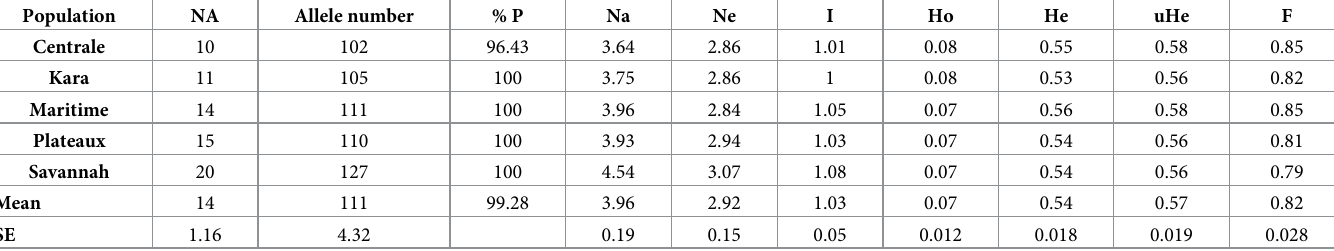
Table 4. Summary of different cowpea population diversity statistics averaged over the 28 SSR loci. Population NA Allele number % P